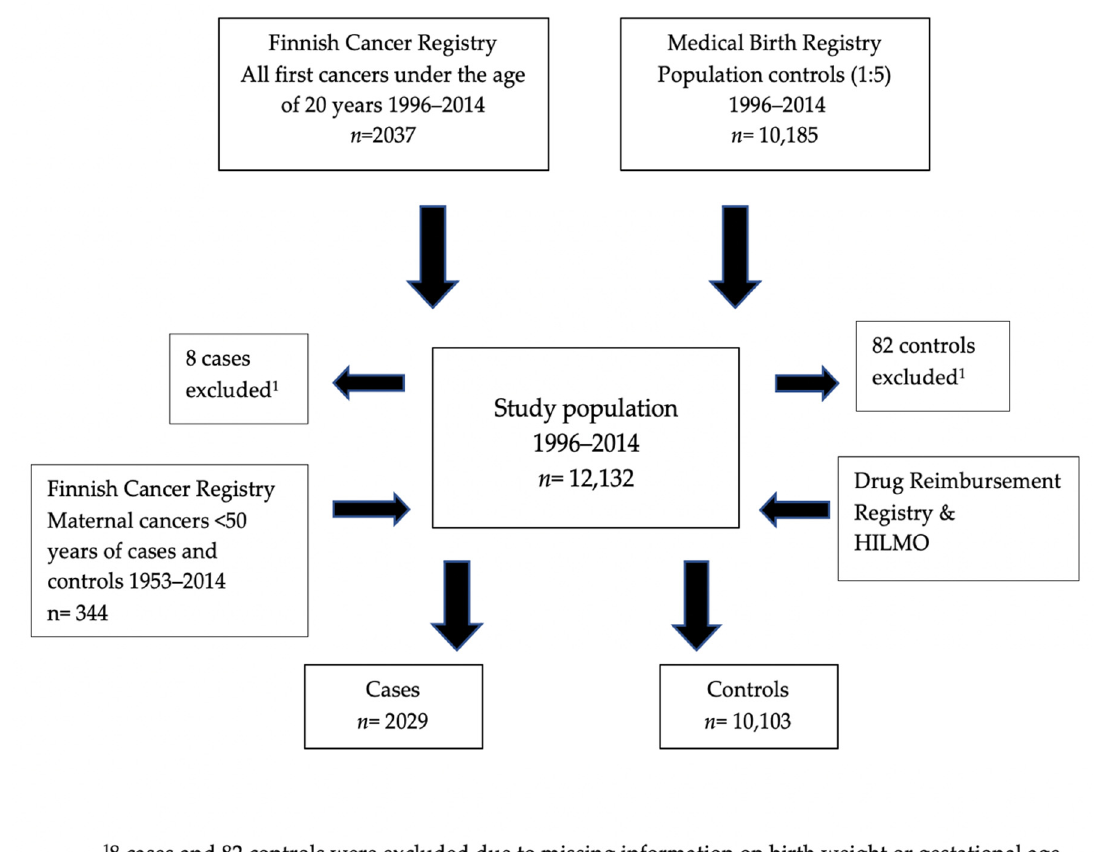
Figure 1. The data compilation for the years 1996–2014.